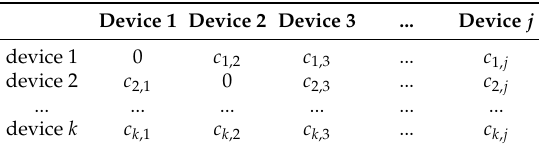
Table 2. LTE-D2D CQI